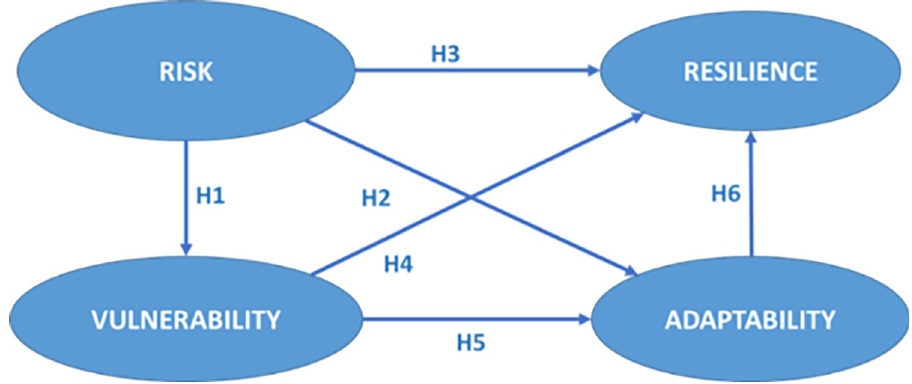
Fig 1. Supply chain resilience model. Source: By the